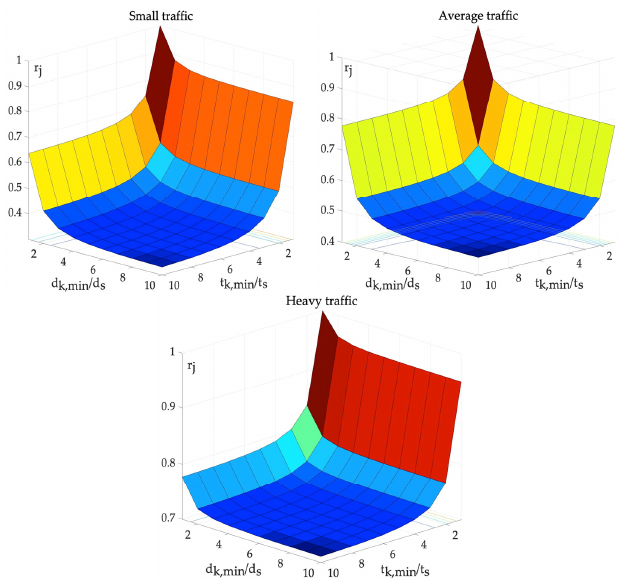
Figure 4. Collision risk surfaces for the three intensities of the traffic situation passing the mobile robot with the k th encountered mobile robot: small traffic— ζ d = 0.6; ζ t = 0.3; d k / d s = 10; average traffic— ζ d = 0.4; ζ t = 0.4; d k / d s = 5; heavy traffic— ζ d = 0.1; ζ t = 0.4; d k / d s =